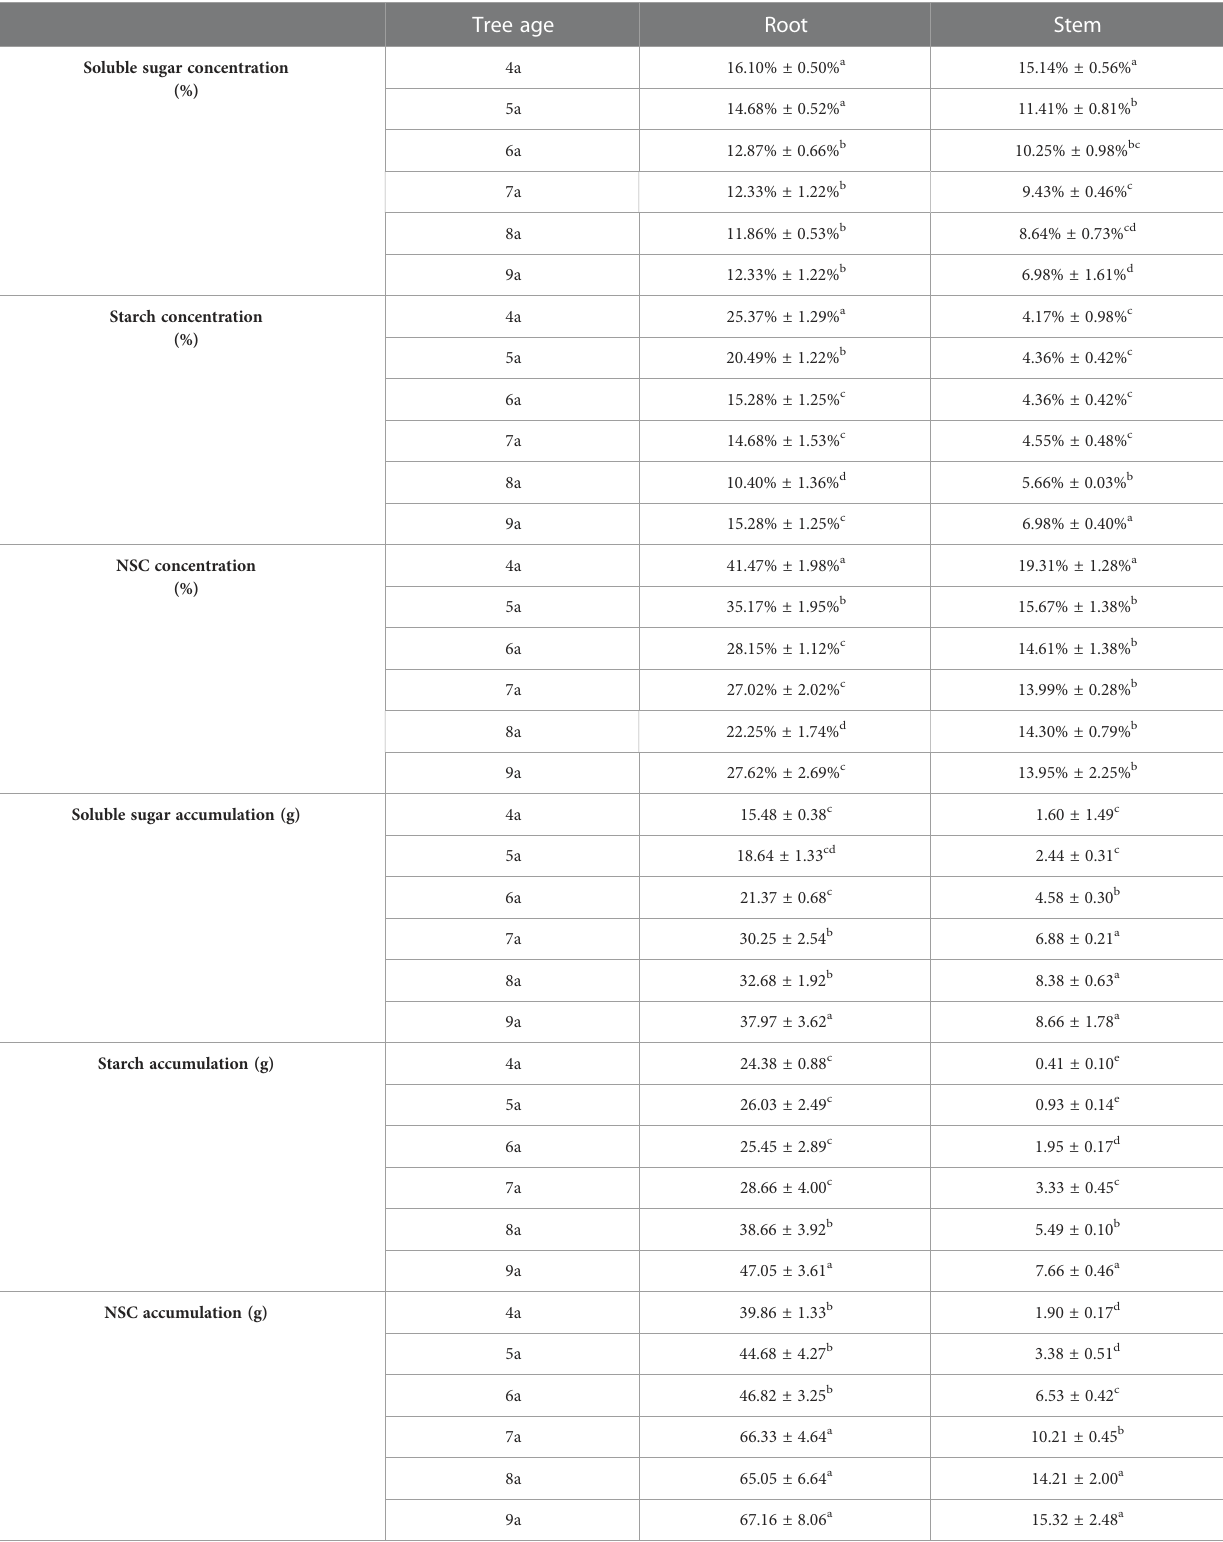
TABLE 3 Average values of the concentrations and accumulations soluble sugar, starch, and NSC of each organ and whole-plant of Fengdan during